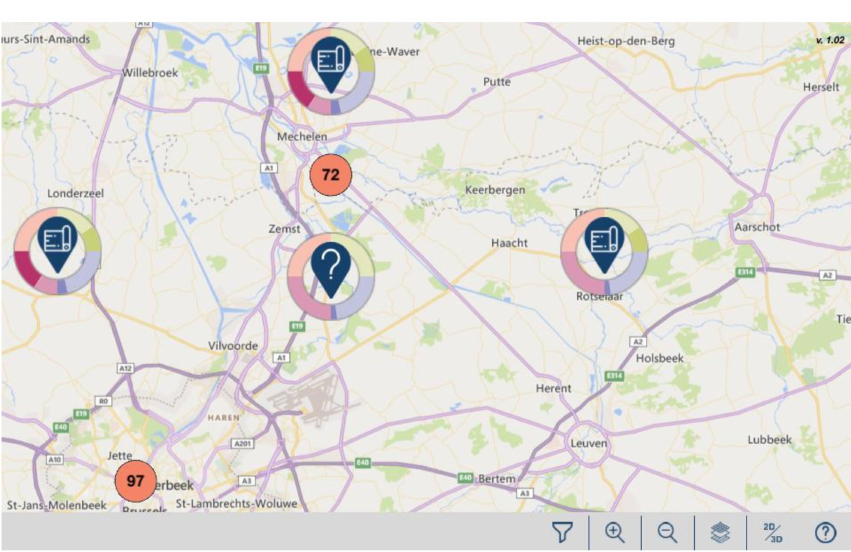
Figure 2. WGS84-based map and some examples of clusterization (with 72 and 97 items